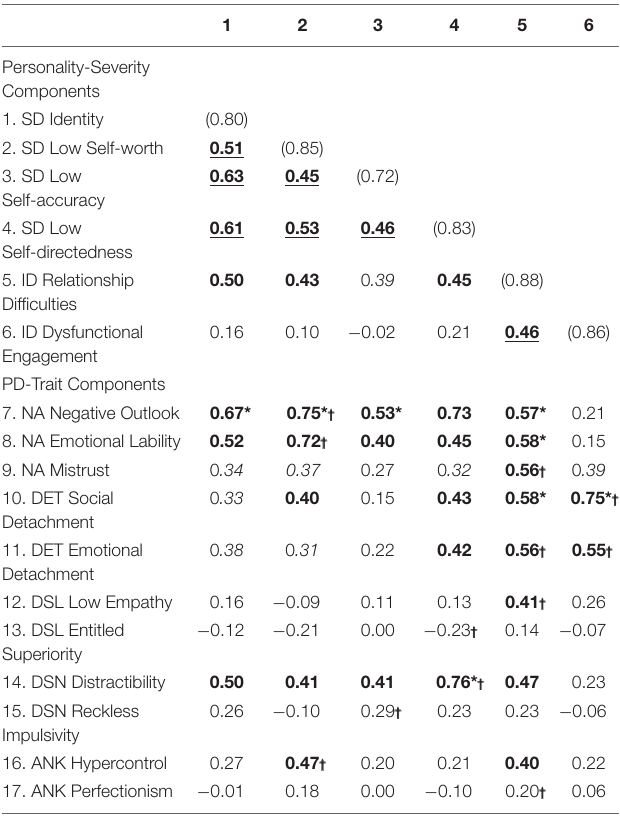
TABLE 4 | ICD-11 personality disorder-severity component scales: Correlations among them and with PD-trait component